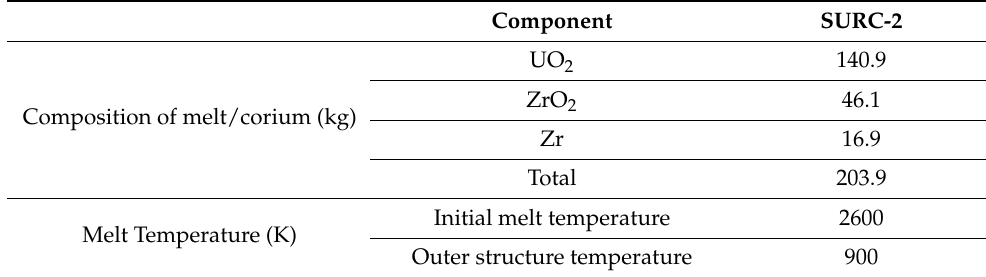
Table 4. Melt/corium composition and its thermal properties for SURC-2.